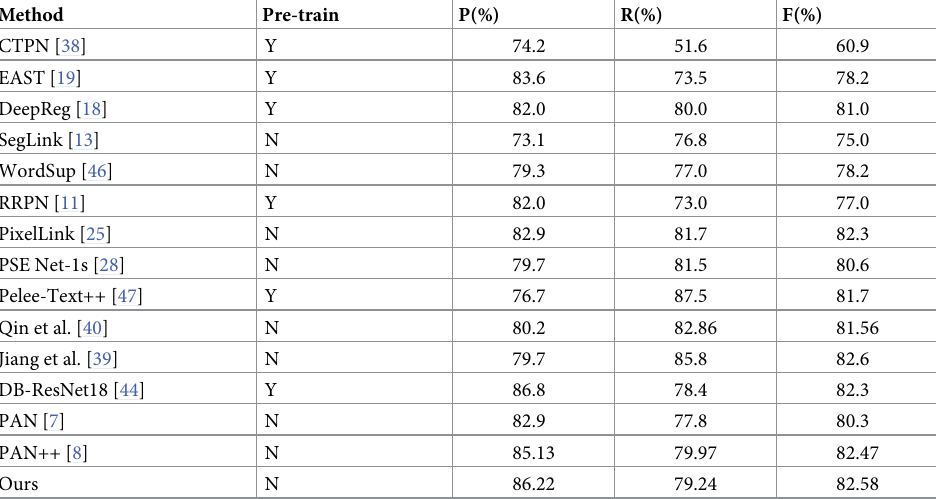
Table 7. Experimental results at dataset ICADR2015 with a scale of 736 × 736, pre-train represents whether to use the pre-training dataset for fine-tuning. “Y” means using pre-training, “N” means not using pre-training. “P”, “R” and “F” stand for “precision”, “recall” and “F-measure” respectively. PAN++ [8] is the detection